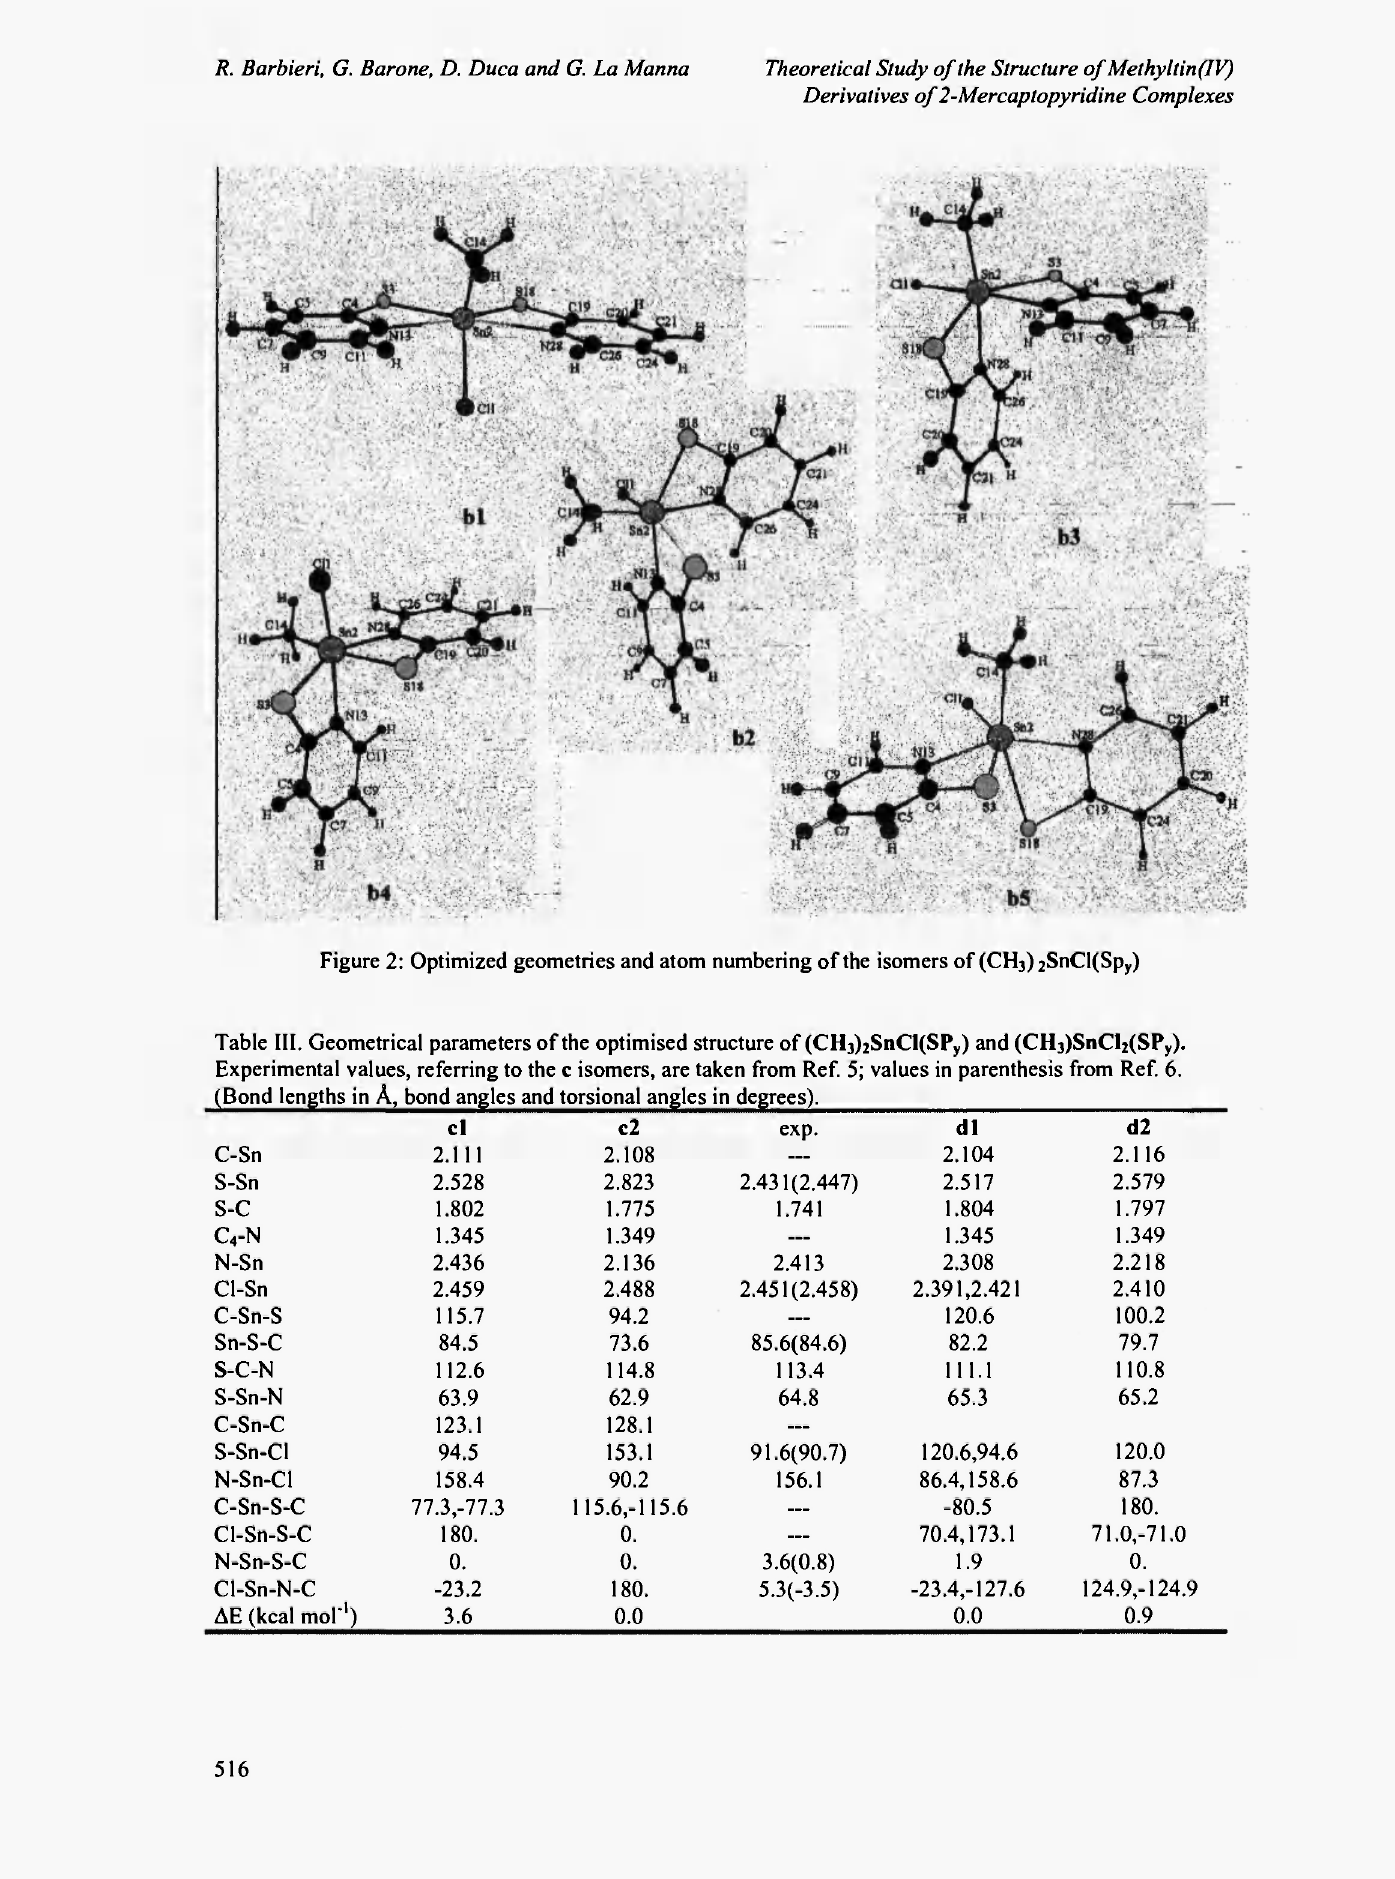
Figure 2: Optimized geometries and atom numbering of the isomers of (CH 3 ) 2 SnCl(Sp y )